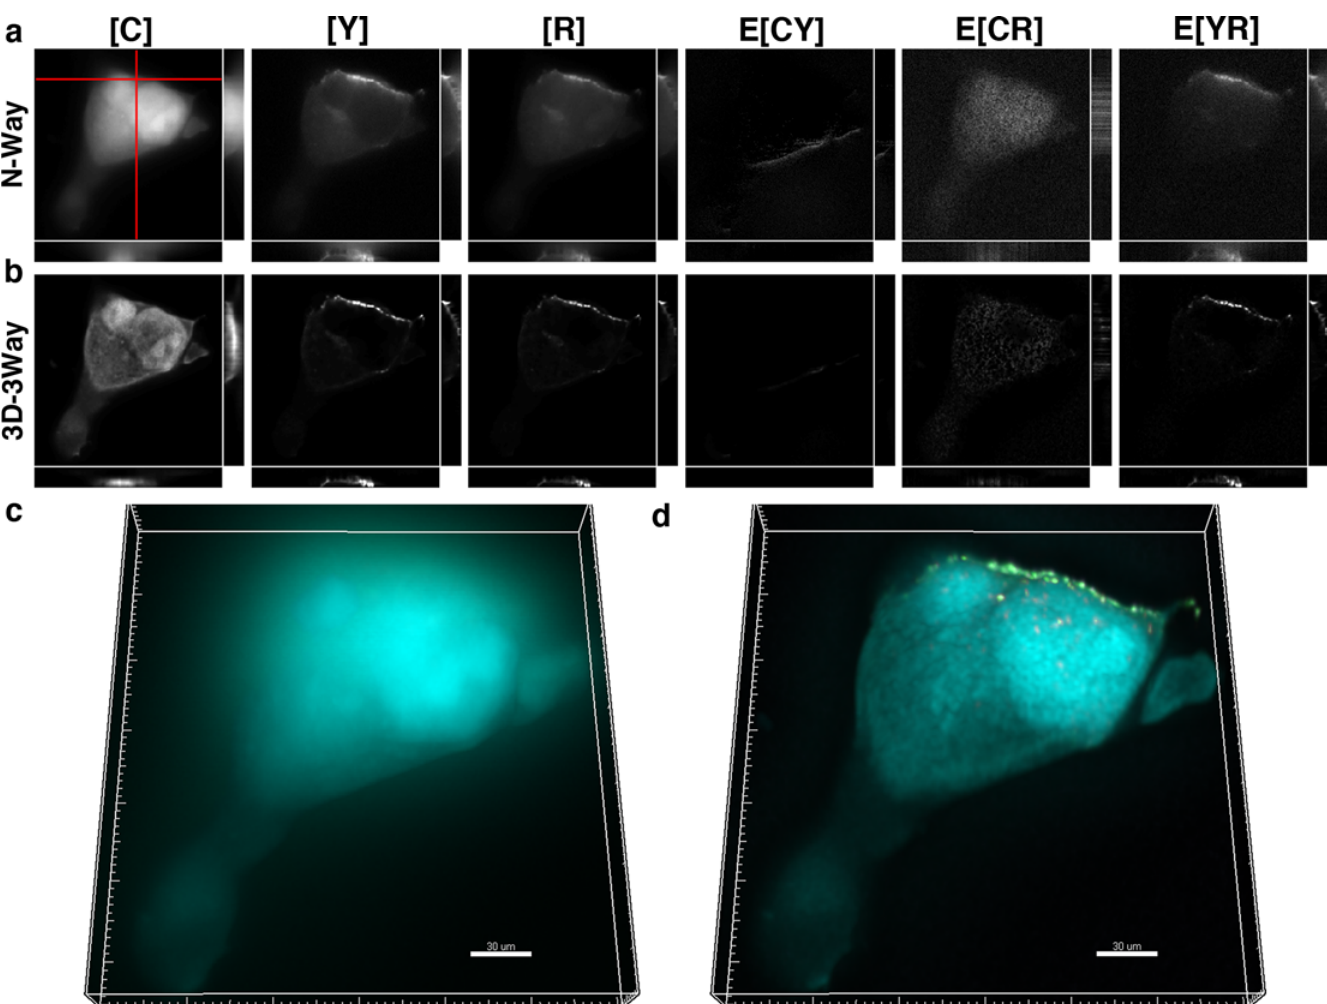
Fig 4. 3D-3Way FRET provides improved estimates for the concentration and localization of HIV-Gag oligomerization in the presence of a noninteracting fluorophore. Cos7 cells expressing cytosolic CFP, YFP-Gag, and RFP-Gag were fixed and imaged 30 hrs post transfection. The oligomerization of Gag into punctate structures can be seen by direct application of N-Way FRET (a), and following 20 iterations of 3D-3Way FRET (b), the FRET complexes exist only in E[YR], are largely restricted to the puncta, and the axial resolution is greatly improved. 3D composite rendering of [C] (cyan) [Y] (green) and E[YR] (magenta) shown following N-Way unmixing (c), and following 3D-3Way reconstruction (d). The reconstructed image highlights the improved resolution.